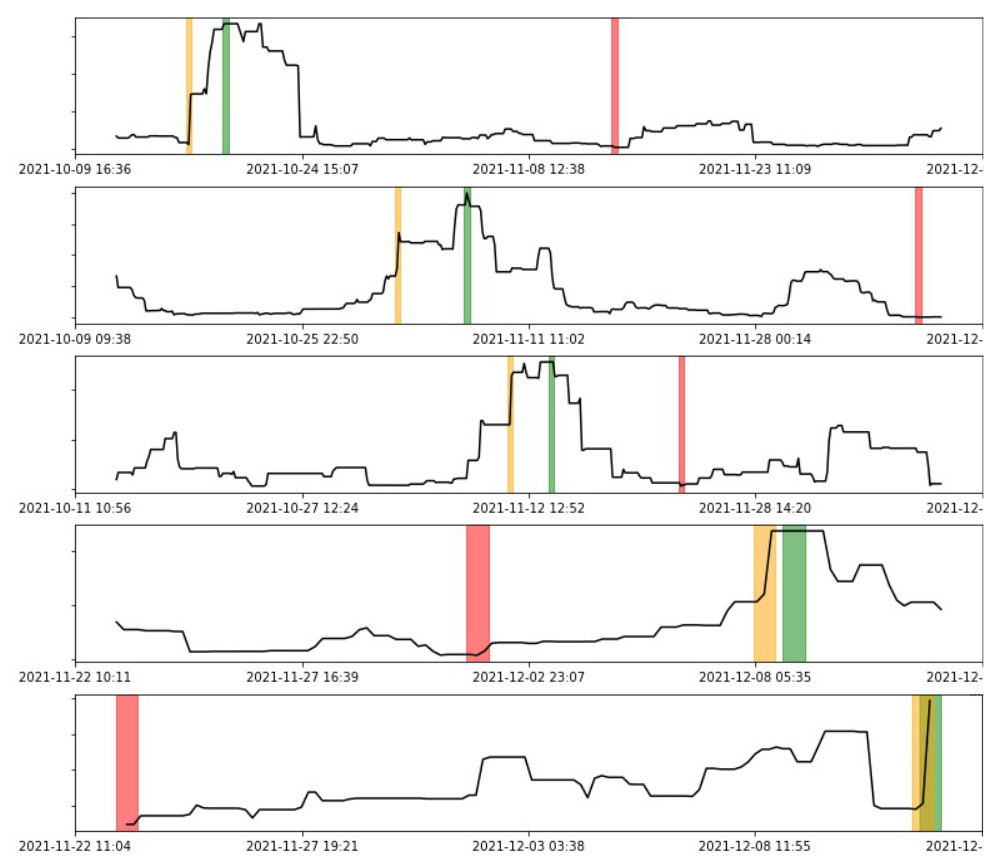
Figure 3. Normalised periodicity intensity for a sample of five student participants. The frequency is 24 h, window size is 7 days and window shift or stride is 3 h. y -axis values have been normalised to the range 0 to 1.